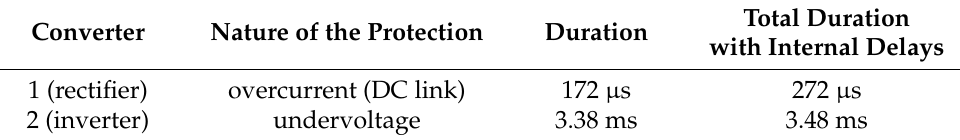
Table 7. Protection method that triggers for each converter with DC circuit-breakers